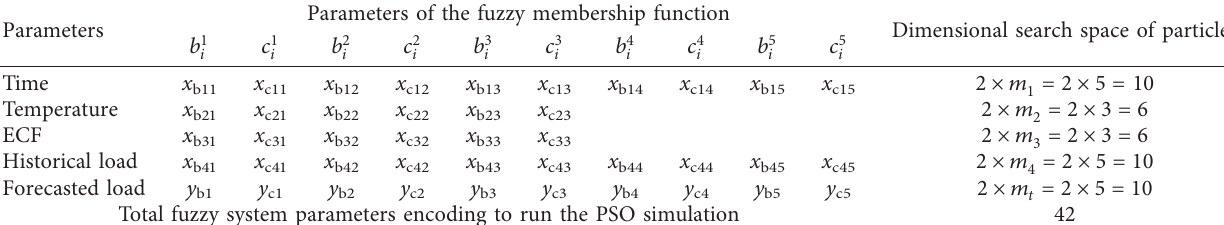
Table 1: The fuzzy parameter encoding using the particles of